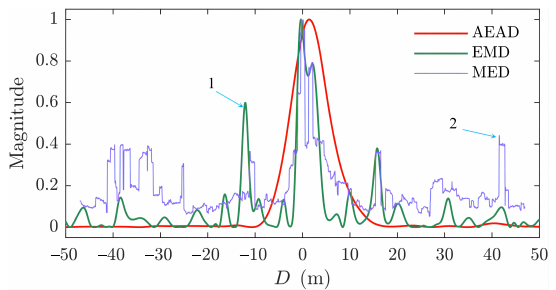
Figure 6. The target detection results of AEAD, EMD and MED methods.